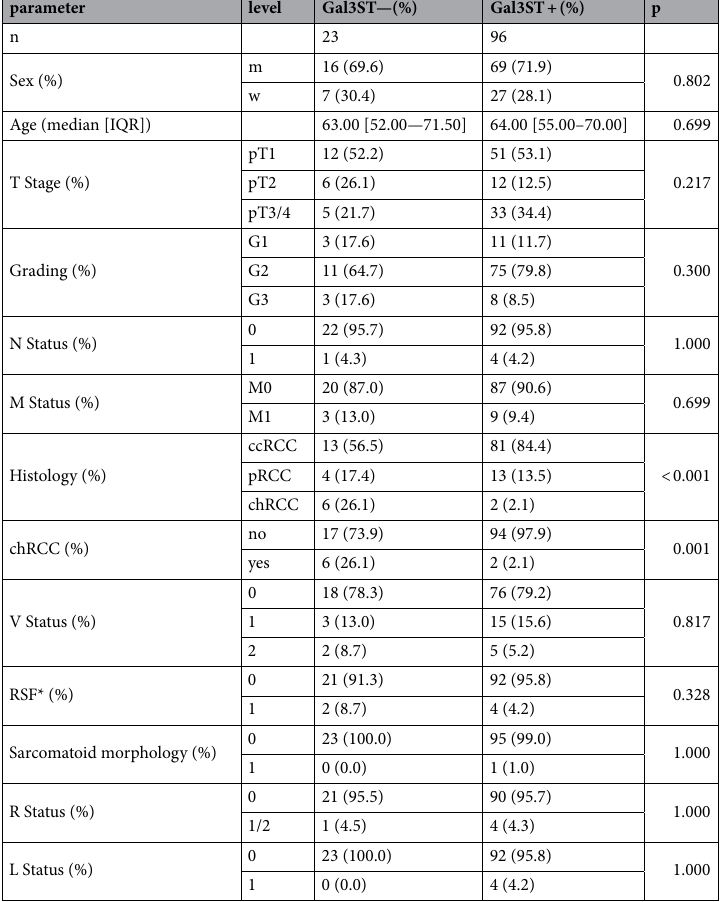
Table 3. Association of Gal3ST1 expression (negative vs. positive) with risk factors (Fisher’s exact test). * RSF renal sinus fat